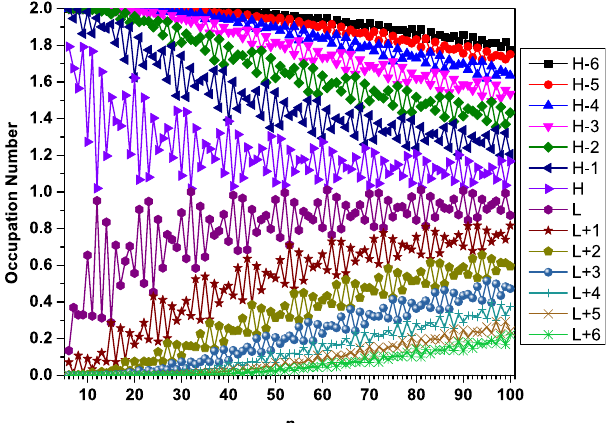
Figure 5. Occupation numbers of active orbitals for the ground state of l -BNR[2, n ] ( n = 6–100), obtained from spin-restricted TAO-LDA. Here, for simplicity, HOMO and LUMO are referred to as H and L, respectively.